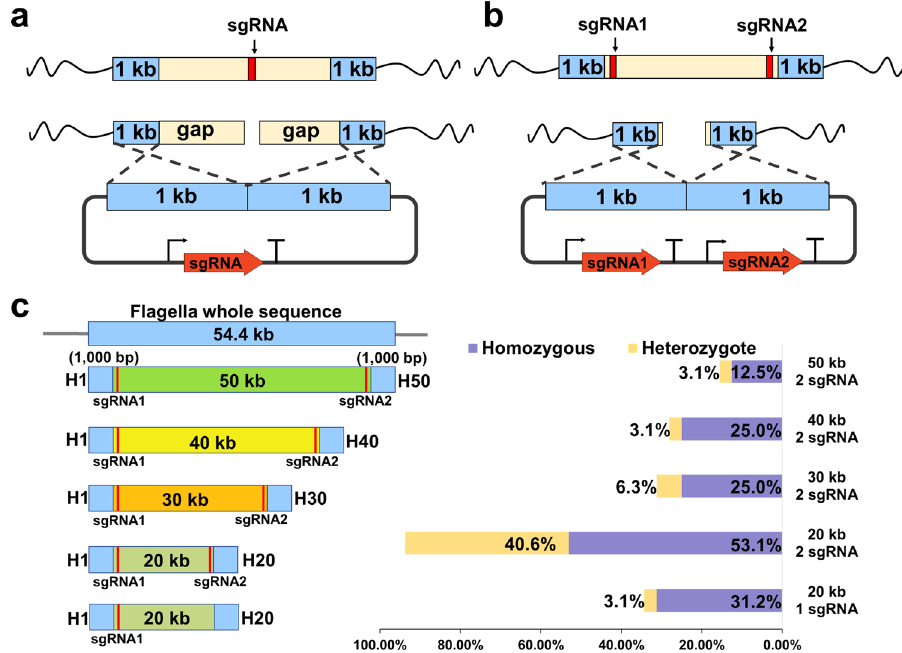
Fig. 1 Flagellar gene cluster deletion using single or double sgRNAs. a , b Design and comparison between single and double sgRNAs. The right-angle arrows and “ T ” symbols represent promoters and terminators, respectively. c Designed positions of homologous arms and sgRNAs for fl agellar gene cluster deletion (left). Editing ef fi ciency of deleting various fl agellar gene cluster with single or double sgRNAs (right). 32 colonies in each group were veri fi ed by PCR. Homozygous genotype (purple) means the deletion of fl agellar cluster in mutants which produce one PCR product with the size of 2.4 kb. Heterozygous genotype (yellow) represents the occurrence of both wild type and deletion of fl agellar cluster in mutants which produce two PCR products with the size of 2.4 and 1.7 kb, respectively. The electrophoresis results of PCR products were shown in Supplementary Fig. 1. H1, the upstream homologous arm of fl agellar gene cluster; H20 (H30, H40, and H50), the downstream homologous arm of fl agellar gene cluster for the deletion of 20 kb (30, 40, and 50 kb)